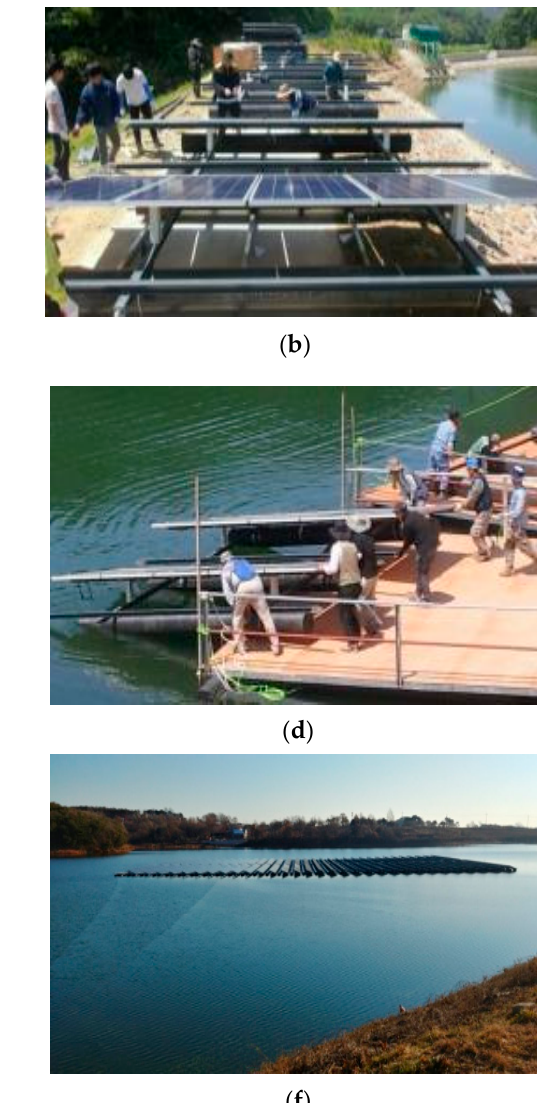
frame assembly; ( b ) photovoltaic module installation; ( c ) lifting; ( d ) launching; ( e ) assembly on water